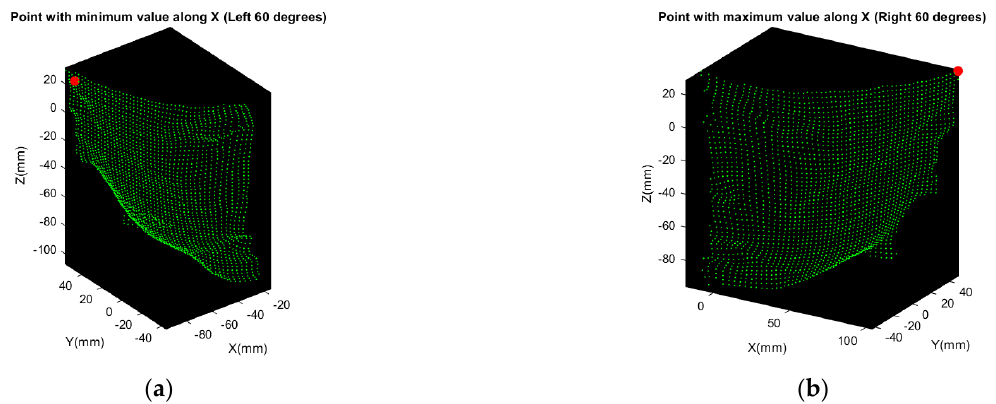
Figure 11. Detection of extremum points along X direction, both are marked as red point: ( a ) point with minimum value along X axis of C point cloud; ( b ) point with maximum value along X axis of E point cloud.